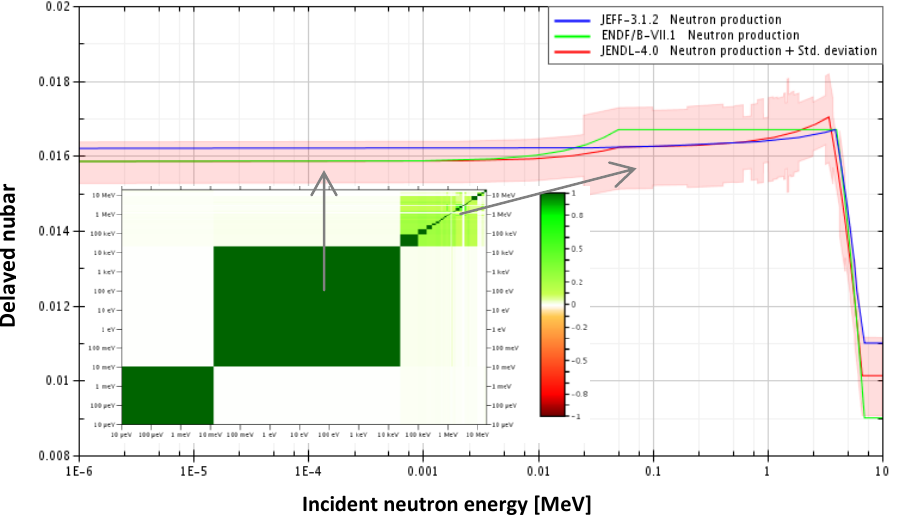
Fig. 1. The evaluated average number of delayed neutrons for 235 U(n,f). The inset shows covariances from JENDL-4.0 and the arrows show where they contribute to the